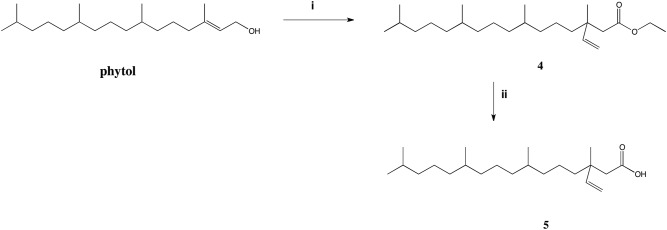
Synthesis of acid (5).Reagents (i) CH3C(OEt)3, CH3COOH, 138°C; (ii) KOH, EtOH.